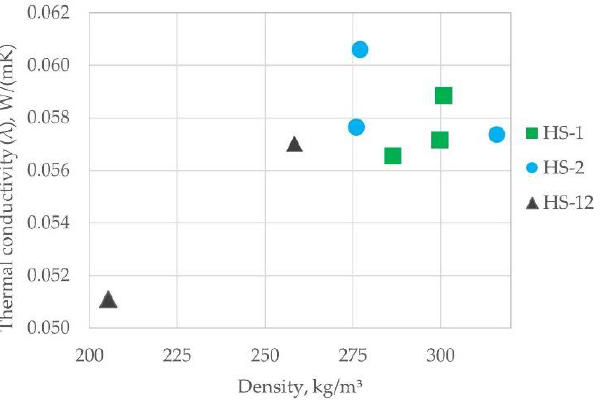
Figure 10. Thermal conductivity values for hemp shive samples produced in the study.